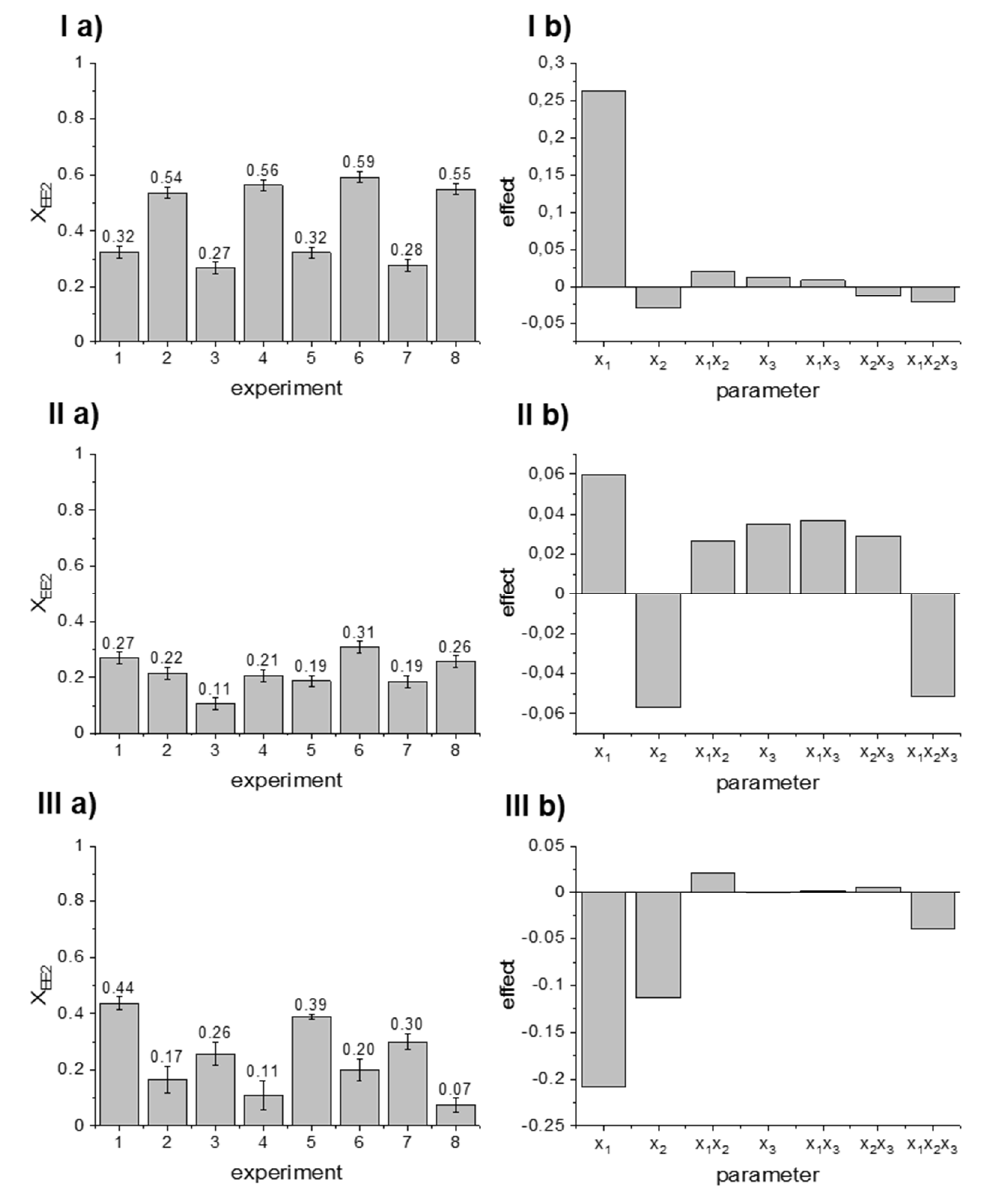
Figure 8. Optimization of the microgap reactor parameters catalyst mass (related to the catalyst bed thickness), solution film thickness and irradiance with combinatorial experiment designs; ( I ) x 1 : residence time τ : τ − = 0.5 min, τ + = 2.0 min; x 2 : average catalyst layer thickness d avg. : d avg. − = 100.10 ± 9.13 µ m (m P25, − = 0.85 g), d avg.+ = 149.70 ± 11.94 µ m (m P25,+